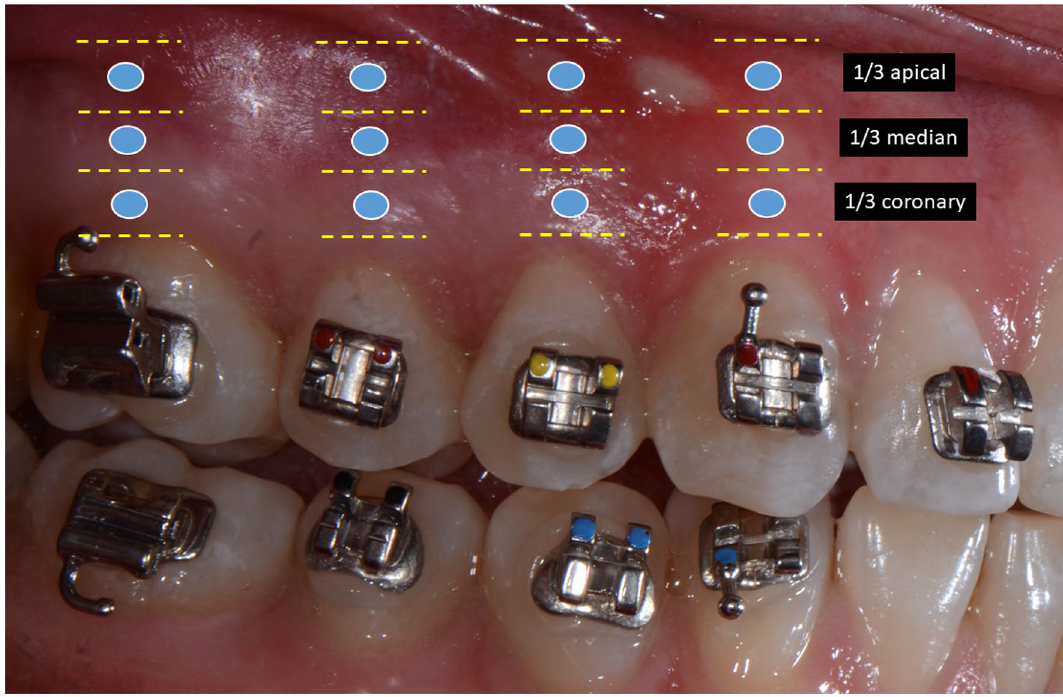
Figure 1. Vestibular laser application